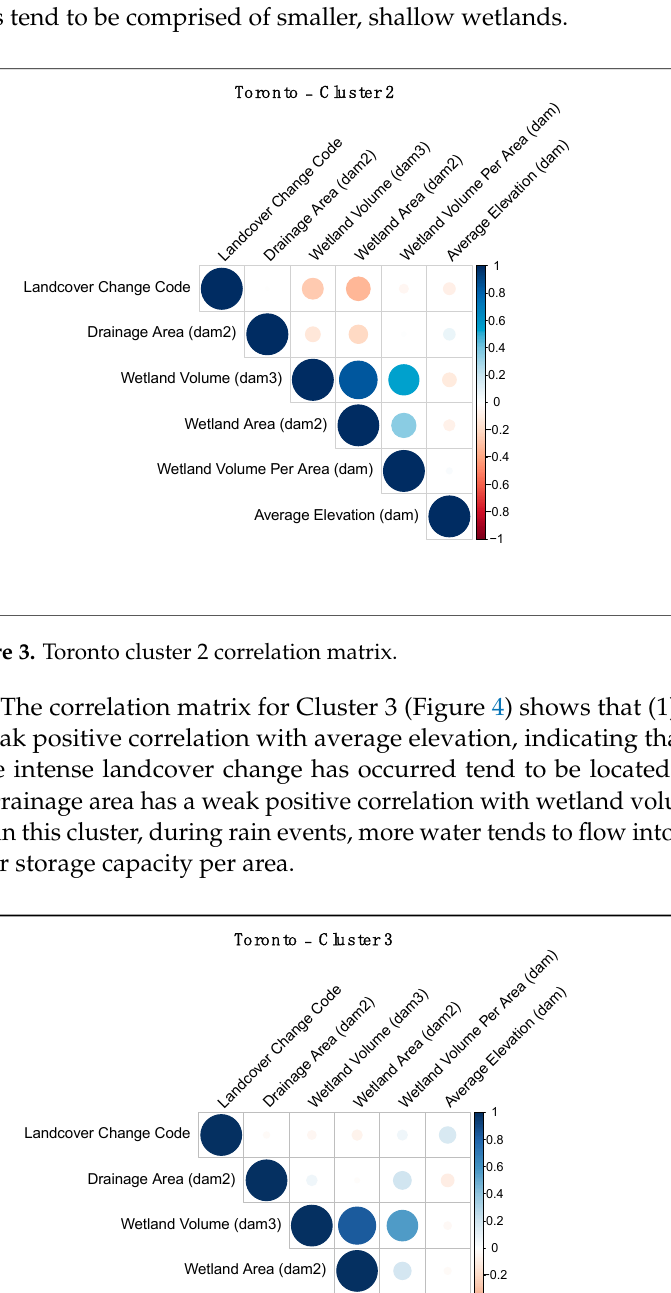
Figure 2. Toronto cluster 1 correlation matrix.